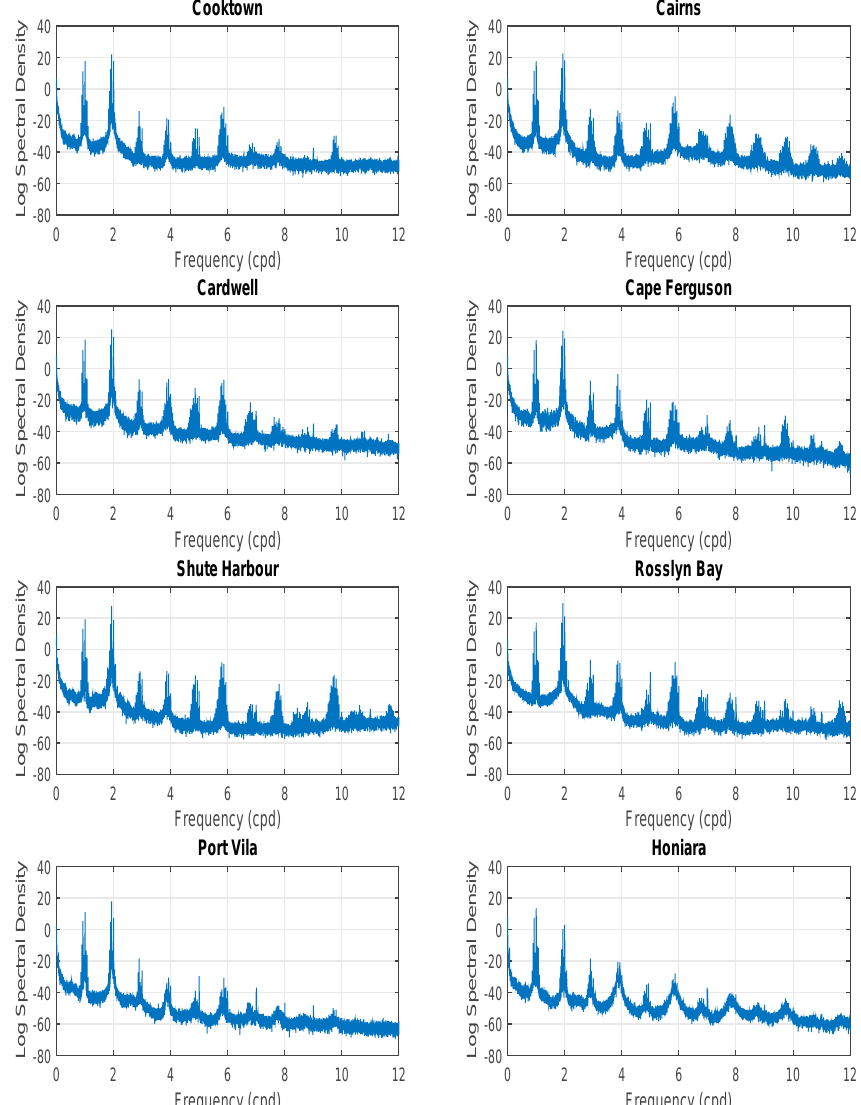
Figure 8. PSD of measured SLA from tide gauges located on the northeast coast of Australia, Vanuatu, and the Solomon Islands. Scales are identical in all graphs.